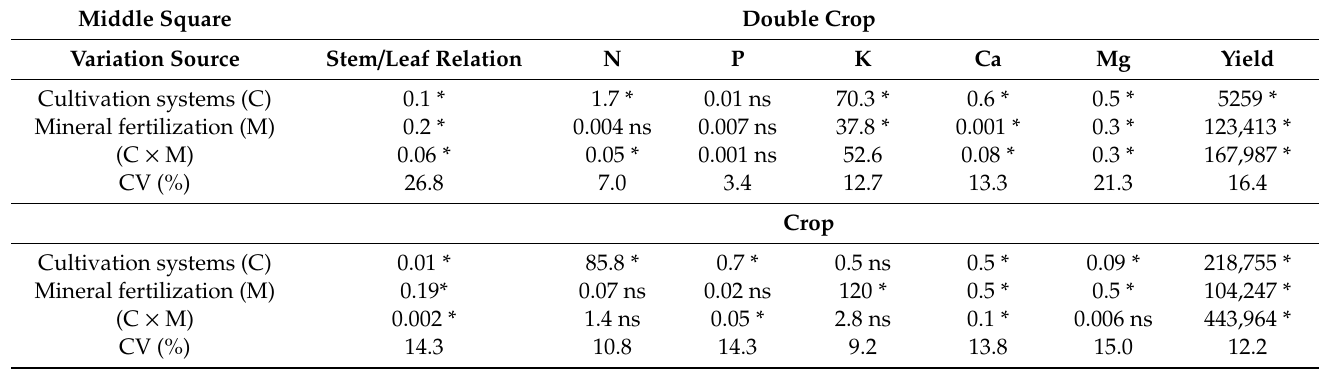
Table 4. Summary of the analysis of variance of the stem leaf ratio, foliar macronutrient content, and forage sorghum yield submitted to the combination of alleys and mineral